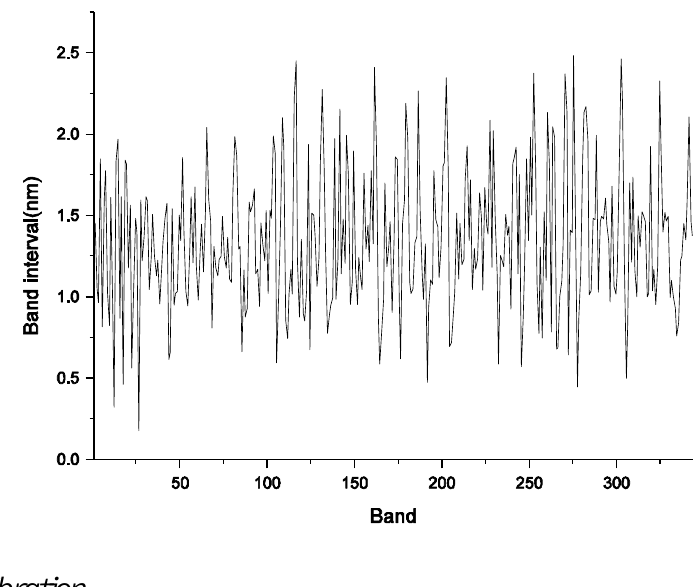
Figure 9. Spectral sampling intervals between adjacent channels of the